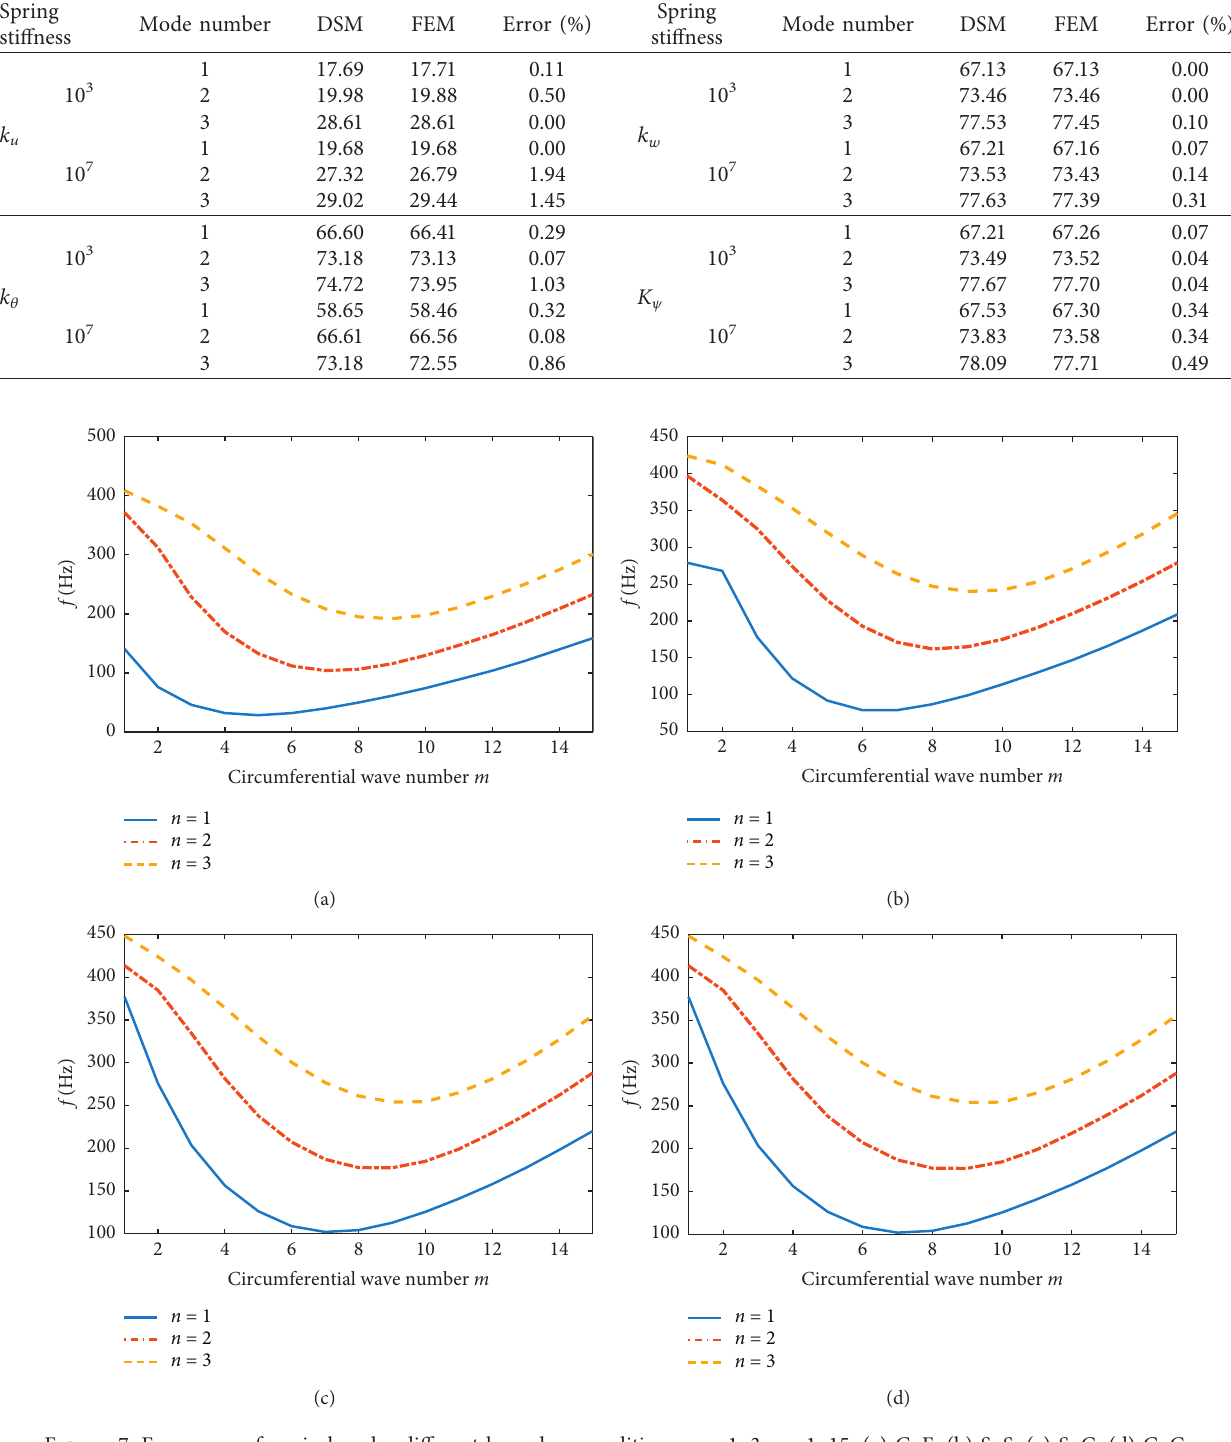
Table 3: Frequency comparison of conical shell under elastic boundary conditions